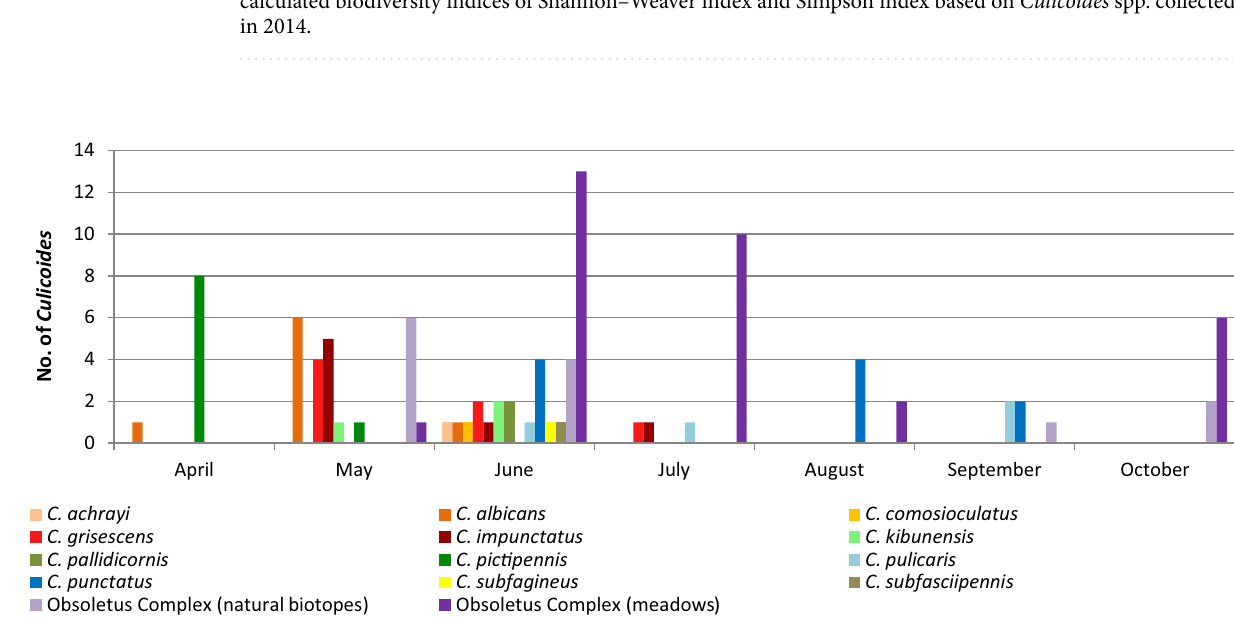
Figure 3. Phenology of Culicoides spp. based on all study sites sampled during